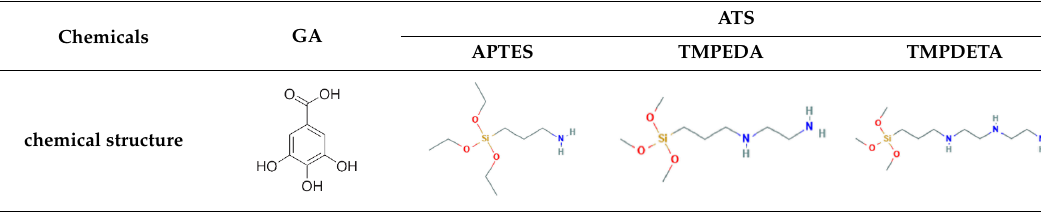
Table 1. Specifications of poly(tetrafluoroethylene) (PTFE) substrates used in this study. Substrates Table 2. Chemical structures of 3,4,5-trihydroxybenzoic acid (GA), 3-aminopropyltriethoxysilane